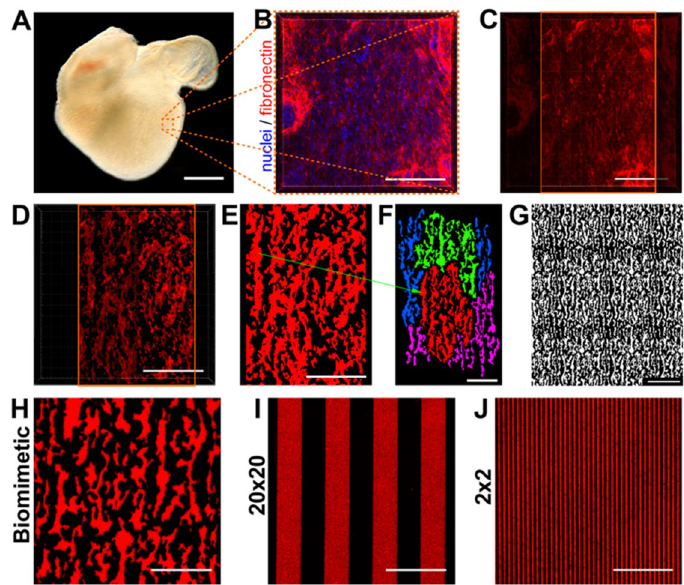
Figure 1. Approach to engineer a biomimetic 2D micropattern based on fibronectin ECM in the left ventricle of the embryonic chick heart. ( A ) Darkfield image of a 6-day-old embryonic chick heart. ( B ) Representative confocal 3D image (top down) of embryonic chick myocardium stained for nuclei (blue) and fibronectin (red). ( C ) The region of image in ( B ) used for the pattern generation, removing the nuclei and the high-intensity fibronectin areas on the edges corresponding to forming blood vessels. ( D ) Image in ( C ) processed to remove any features less than 1 µm in length, which are below the resolution of the photomask to be made. ( E ) Max intensity projection of the fibronectin ECM in ( D ) and conversion to a binary image. ( F ) The biomimetic pattern unit cell used in this study, composed of parts of four separate images combined into a single image, where each color represents the features from a specific image. The red region corresponds to the red pattern in ( E ), with the green arrow showing an example of a transferred feature. ( G ) The biomimetic unit cell in ( F ) is arrayed in 2D to create large area patterns in the photomask. ( H ) Representative image of the biomimetic micropattern microcontact printed using fluorescently-labeled fibronectin on PDMS-coated coverslips, confirming the fidelity of the protein transfer. ( I and J ) Representative images of the control micropatterns consisting of fibronectin ( I ) 20 × 20 and ( J ) 2 × 2 line patterns. Scale bars are ( A ) 500 µm, ( B-F ) 50 µm, ( G ) 100 µm, and ( H-J ) 50 µm. GIMP software was used to generate and edit the pattern (https:// www. gimp. org/ downl